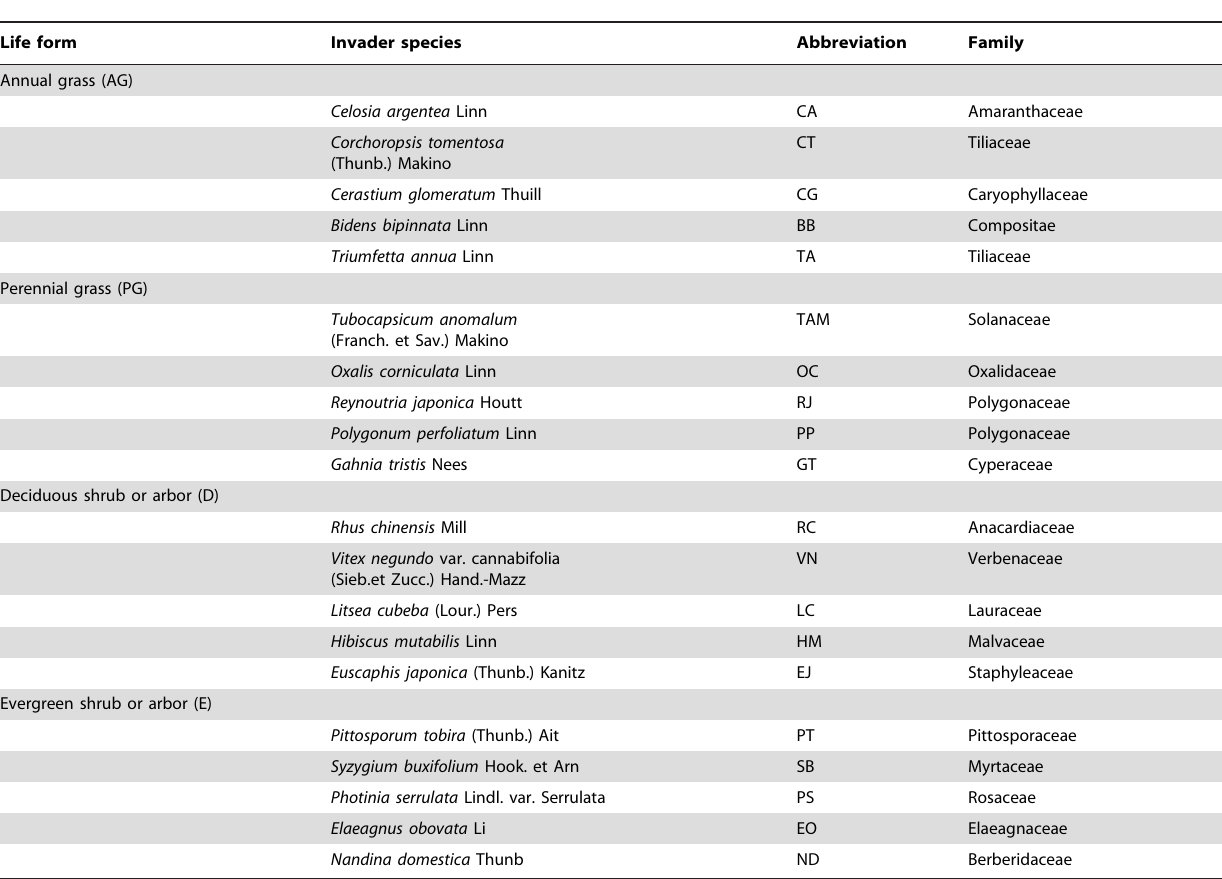
Table 2. The sown invader species in the experimental pots.